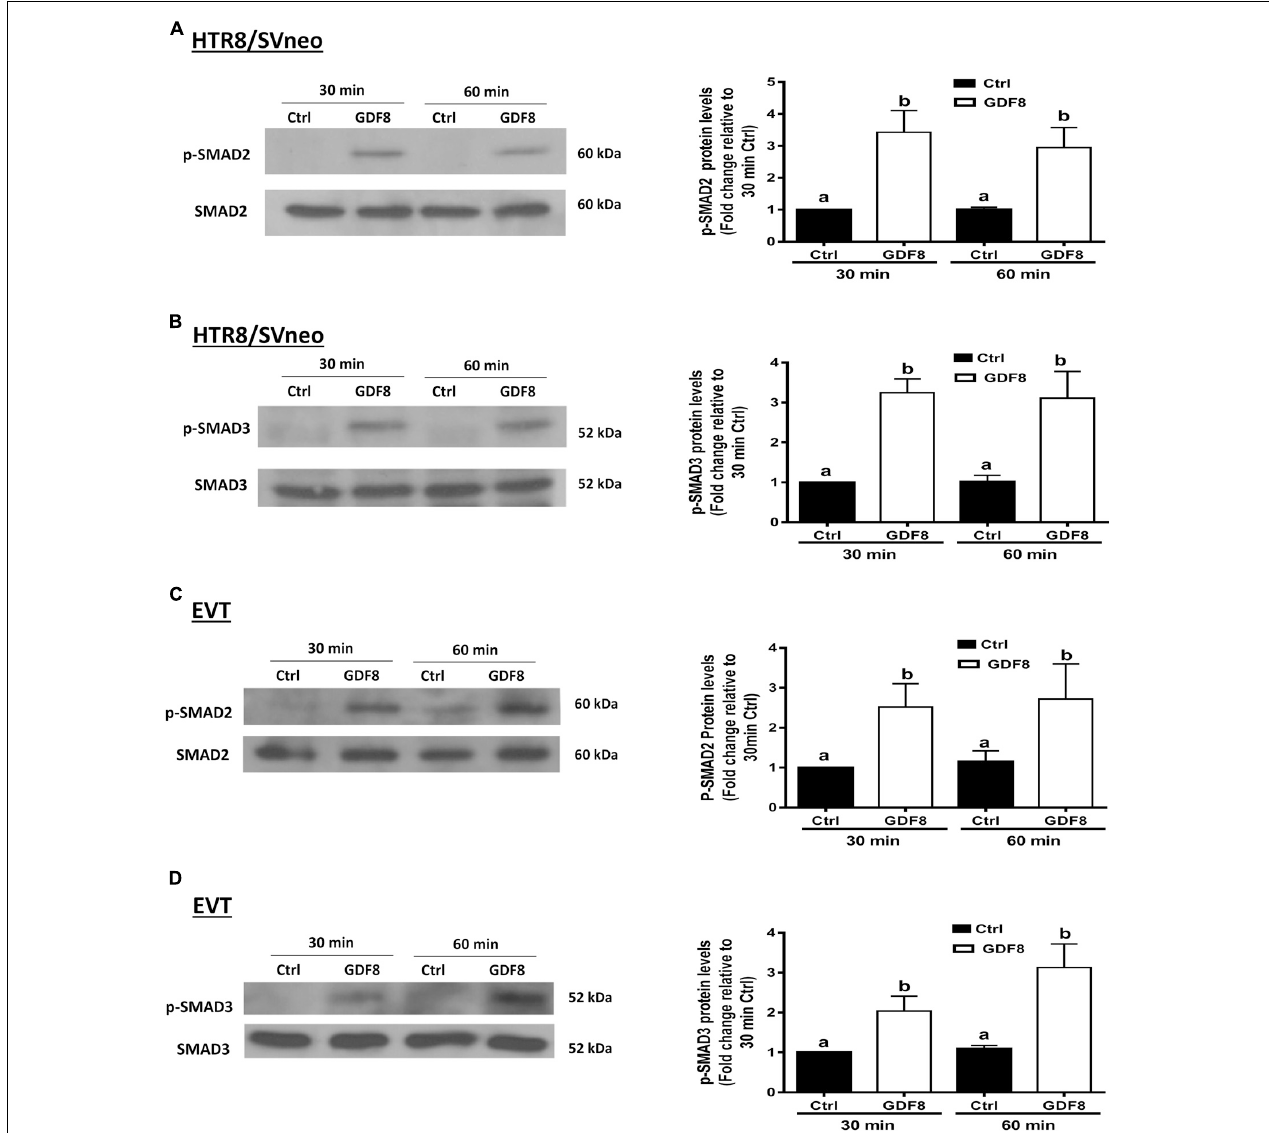
FIGURE 4 | Growth differentiation factor 8 (GDF8) increases the phosphorylated protein levels of SMAD2 and SMAD3 in HTR8/SVneo and primary EVT cells. HTR8/SVneo (A,B) or primary EVT (C,D) cells were treated for 30 or 60 min with the vehicle control (Ctrl) or 25 ng/mL GDF8. The phosphorylated protein levels of SMAD2 (A,C) and SMAD3 (B,D) were examined using western blot analysis. SMAD2 and SMAD3 were used as the loading control and references for densitometric analysis for p-SMAD2 and p-SMAD3, respectively. The results are displayed as the mean ± SEM of at least three independent experiments, and the values with different letters are significantly different ( P <